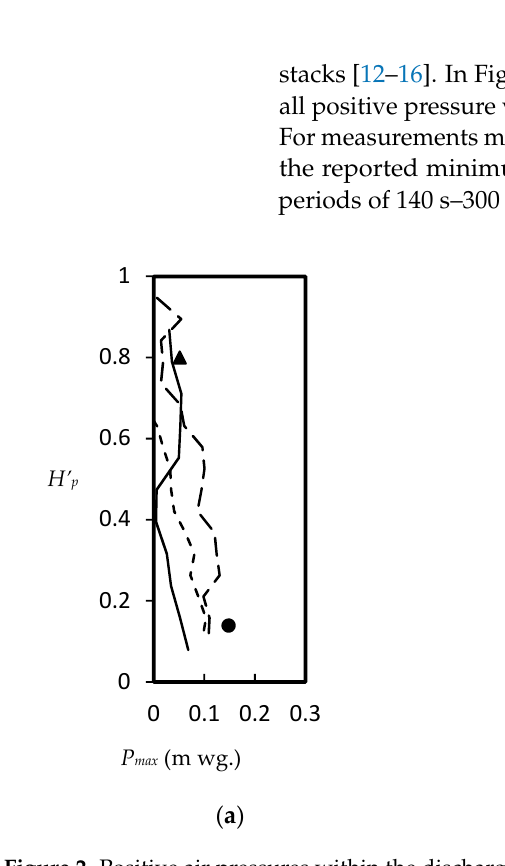
Figure 2. Positive air pressures within the discharging drainage stacks ( H = 38–115 m) of an experimental tower and some in-use buildings: ( a ) maximum air pressure; ( b ) probability of positive air pressure.